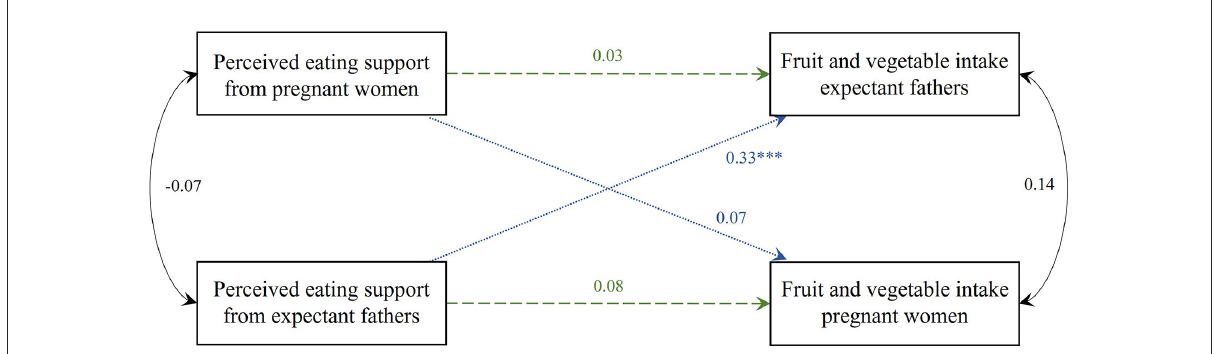
FIGURE4 Actor-Partner Interdependence Model of the relation between perceived eating support and fruit and vegetable intake corrected for total energy intake in women and men. Standardized parameter estimates are shown, *** p < 0.001. Model corrected for family income (between-dyad covariate), BMI and age (within-dyad covariates). Green dashed line, actor-effect; blue dotted line, partner-effect; BMI, body mass index.